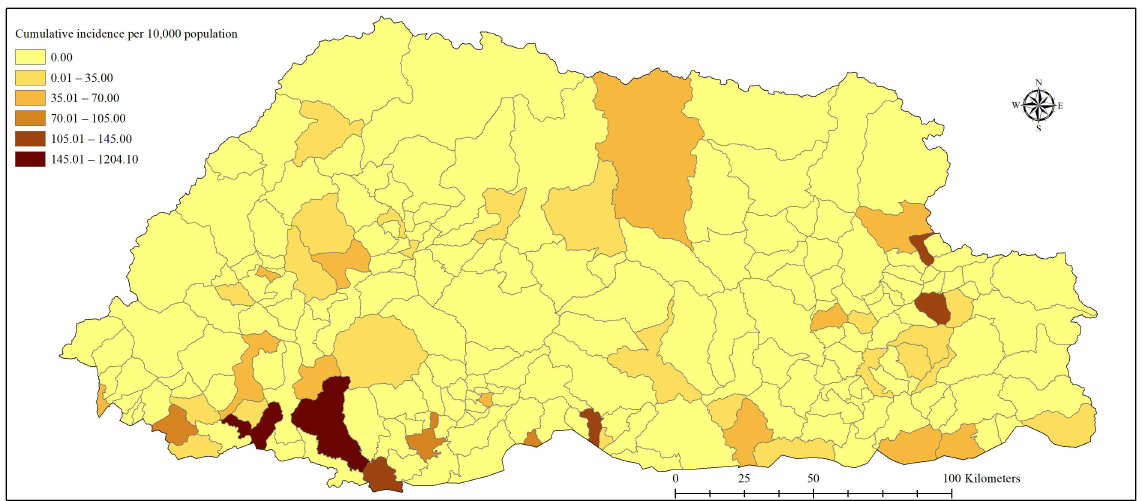
Figure 2. Distribution of cases by cumulative incidence by subdistrict during dengue epidemic in Bhutan, from weeks 18–49. Subdistricts with the darker color include Phuntsholing, Bongo, Gelephu, Lhamozingkha, and Khamdang subdistricts. Khamdang subdistrict in the top central-eastern region saw a cluster of cases ( ≈ 70 cases) for the first time in this